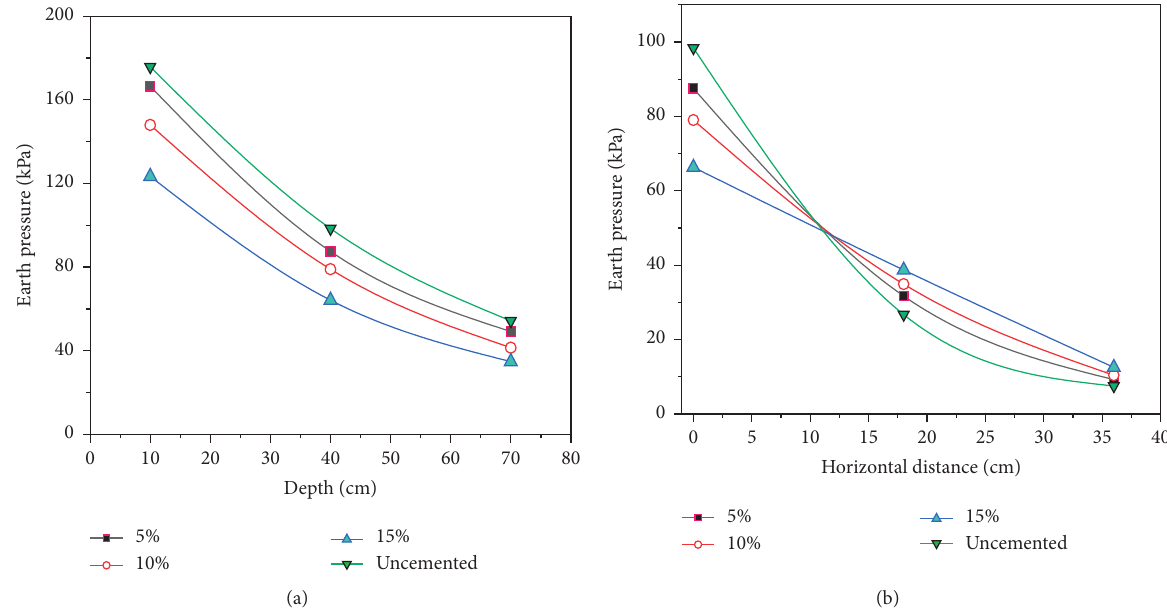
Figure 14: Earth pressure distribution of calcareous sand in different positions ( P � 200kPa): (a) depth (cm) and (b) horizontal distance (cm).